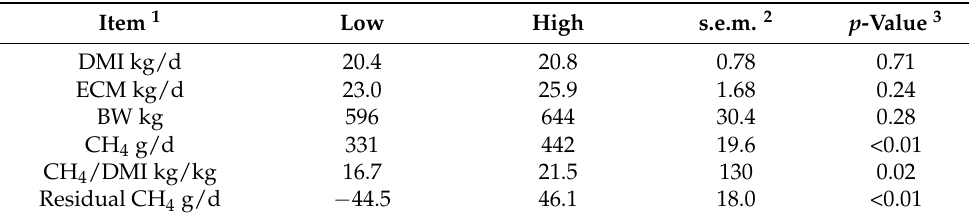
Table 2. Comparison of least square means for cow performance and gas production of the selected low and high CH 4 emitter groups in vivo ( n = 7 pairs of cows).